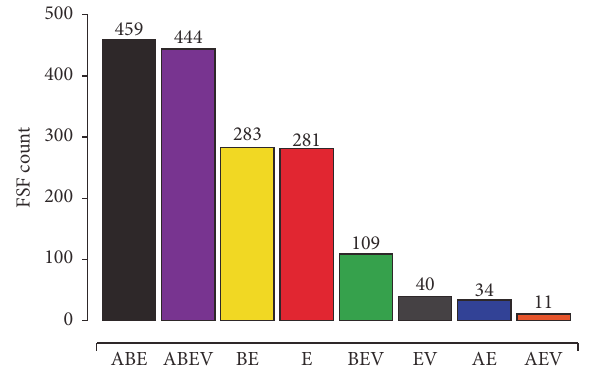
Figure 1: The global nature of eukaryotic proteomes. A total of 1,661 FSFs were detected by the SUPERFAMILY hidden Markov models [44, 45] in proteins coded by 383 completely sequenced proteomes of eukaryotes (FSF assignments of Lokiarchaeum were added a posteriori to data taken from [46]). Bars display the number of eukaryotic FSFs that either were shared with Archaea (A) and Bacteria (B) and viruses (V) or were unique to eukaryotes